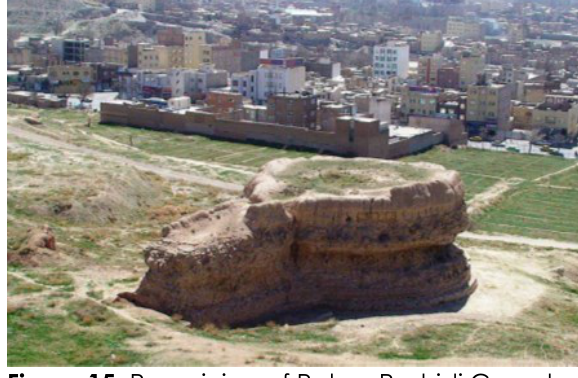
Figure 13 . Sketch Map of Tabriz, Pre-Ilkhanid Urban Organization during 12 th Century A.D.